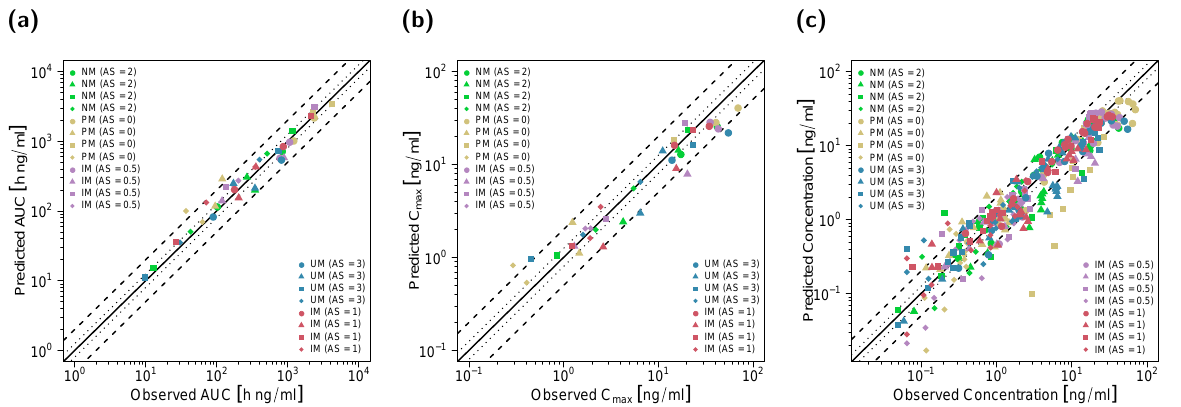
Figure 7. Predicted versus observed AUC last ( a ), C max ( b ) and plasma concentrations ( c ) of ( E )-Clom 1 (circles), ( E )-4-OH-Clom (triangles), ( E )-DE-Clom (squares) and ( E )-4-OH-DE-Clom (diamonds) for DD(G)I scenarios with clarithromycin and paroxetine, respectively. The black solid lines mark the lines of identity. Black dotted lines indicate 1.25-fold; black dashed lines indicate two-fold deviation. AS, CYP2D6 activity score; DD(G)I, drug–drug and drug–drug–gene interactions; ( E )-4-OH-Clom, ( E )-4-hydroxyclomiphene; ( E )-4-OH-DE-Clom, ( E )-4-hydroxy-N-desethylclomiphene; ( E )-Clom, ( E )-clomiphene; ( E )-DE-Clom, ( E )-N-desethylclomiphene; IM, intermediate metabolizers; NM, nor- mal metabolizers, PM, poor metabolizers; UM, ultrarapid metabolizers. The AUC last of ( E )-DE-Clom is substantially reduced in all phenotypes by values between ~70% and 80% (NM and IM) and ~34% (PM) during concomitant clarithromycin administration, demonstrating that CYP3A4 is likely the major enzyme in the forma- tion of ( E )-DE-Clom. During CYP3A4 inhibition, AUC last and C max values, as well as the corresponding DDGI effects for ( E )-4-OH-Clom and ( E )-4-OH-DE-Clom in PM, were overpredicted by ~2.5-fold. Predicted and observed AUC last and C max ratios of ( E )-Clom, ( E )-4-OH-Clom, ( E )-DE- Clom and ( E )-4-OH-DE-Clom for the DD(G)I setting are shown in Figure 8. GMFEs for the predicted C max and AUC last ratios in the DD(G)I setting were 1.50 and 1.40, respectively. All predicted and observed values for AUC last and C max , DD(G)I effect ratios as well as calculated MRDs and GMFEs are listed in Section S4.3 of the supplementary document.